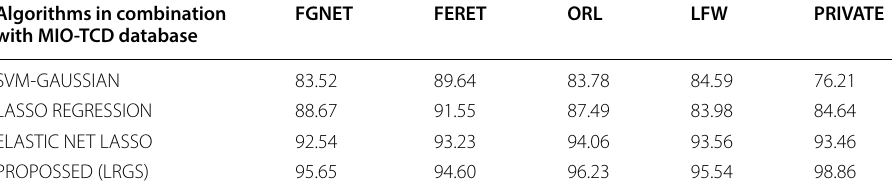
Table 9 Accuracy for different classifiers worked on different databases in combination with MIO-TCD DATABASE Algorithms in combination with MIO-TCD